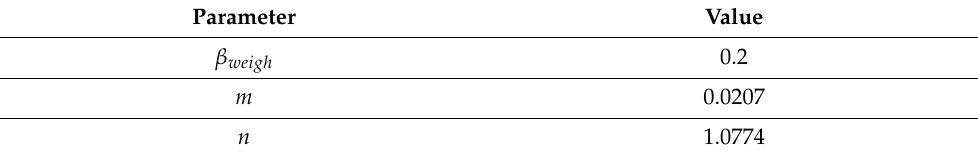
Table 2. Weight model parameters used for the full-scale validation.